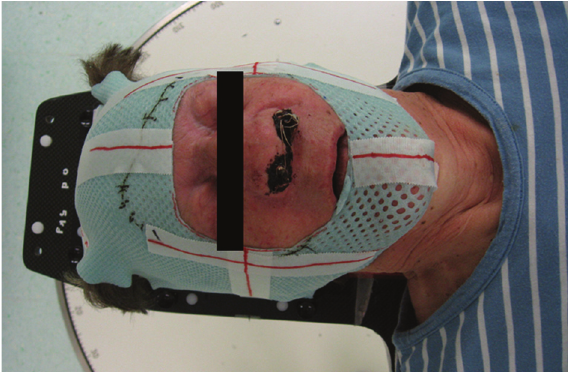
Figure 3: Radiotherapy positioning. Positioning of the patient on the couch. The thermoplastic mask system is used to prevent the patient from moving during the treatment. The lines marked on the mask system are used for the room lasers which are used to define the exact positioning.